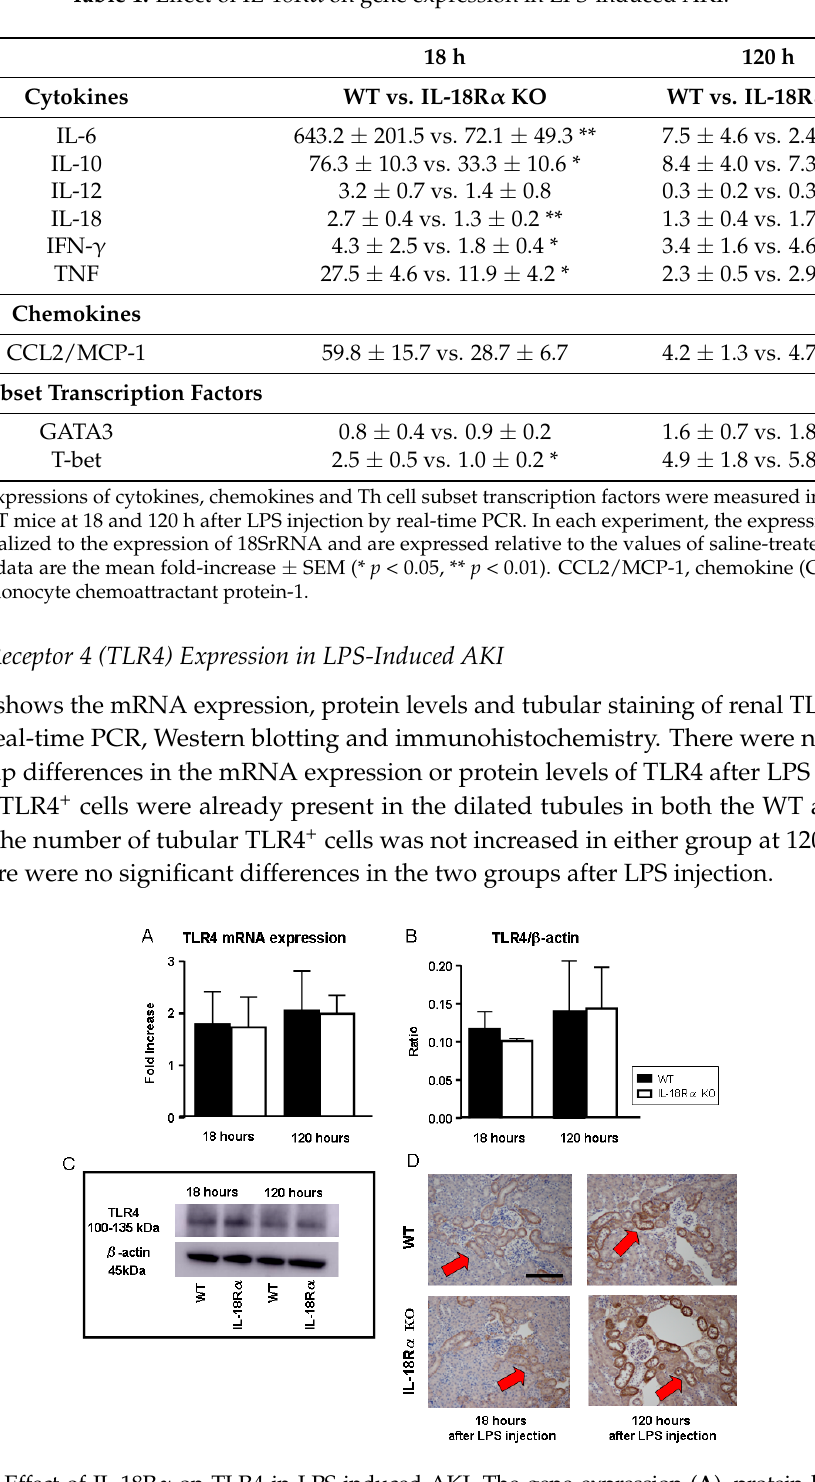
Table 1. Effect of IL-18R α on gene expression in LPS-induced AKI.